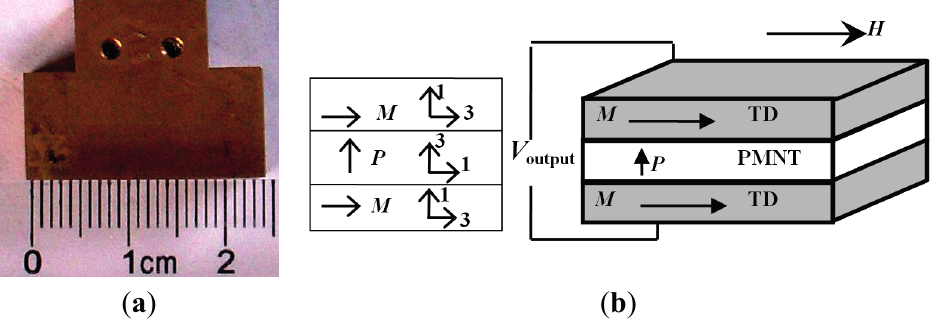
Figure 6. Schematic illustration of the ME sensing unit used in the EME sensor: (a) Photograph; and (b) Working principle, in which the arrows designate the directions of the magnetization ( M ) and polarization ( P ),